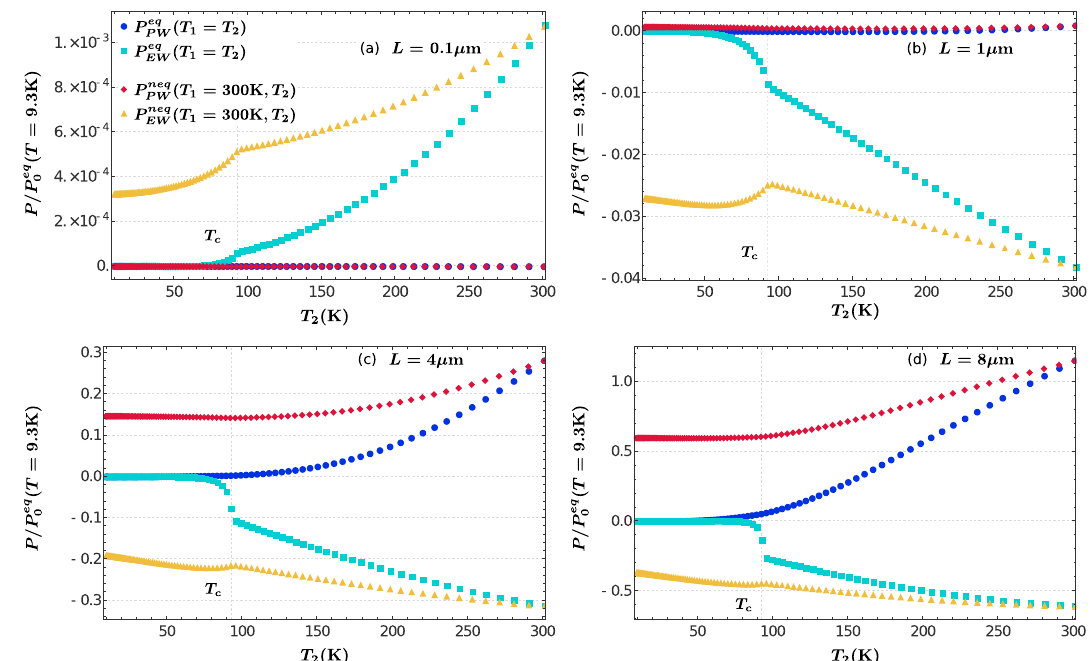
Figure 4. Temperature dependence of the thermal contributions to the Casimir pressure associated with EW and PW modes (according to Eqs. (2)–(4)), for the four cases of plate separation presented in Fig. 3. In each figure, the pressure axis is normalized to the corresponding zero-point contribution specified at the bottom of Fig.